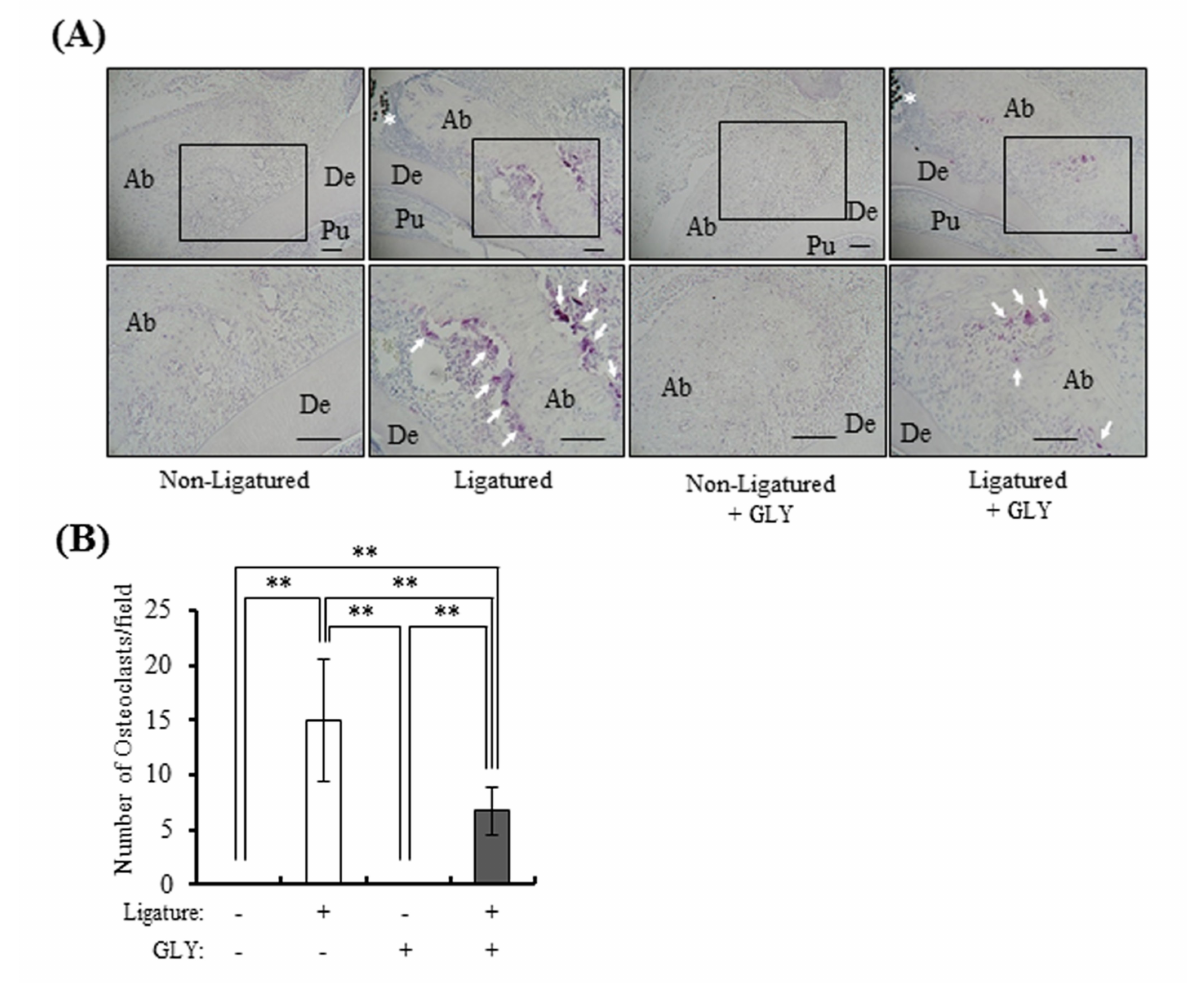
Figure 5. The effect of GLY extracts on osteoclast differentiation in ligature-induced periodontitis. Microscopic observa- tions were performed on the decalcified paraffin sections with TRAP staining on day 4 from the placement of ligature. ( A ) Representative images have shown TRAP-positive osteoclasts in the alveolar bone around maxillary secondary molar in the non-ligatured and ligatured buccal side; upper panels: x100 magnification, lower panels: x200 magnification. Ab, alveolar bone; De, dentin; Pu, pulp; the asterisk indicates the nylon ligature, and the arrowheads indicate TRAP-positive osteoclasts, Scale bars represent 100 µ m. ( B ) Quantitative analysis of TRAP-positive osteoclasts on day 4 in the ligatured buccal and palatal side. TRAP-positive cells per visual field, counted 16–24 visual fields. Data are presented as the mean ± SD from four or six rats per group. Double asterisk indicates p < 0.01. Control; group of oral administration of distilled water for four days ( n = 4), GLY admin.; group of oral administration with 60 mg/kg of GLY extracts for four days ( n =